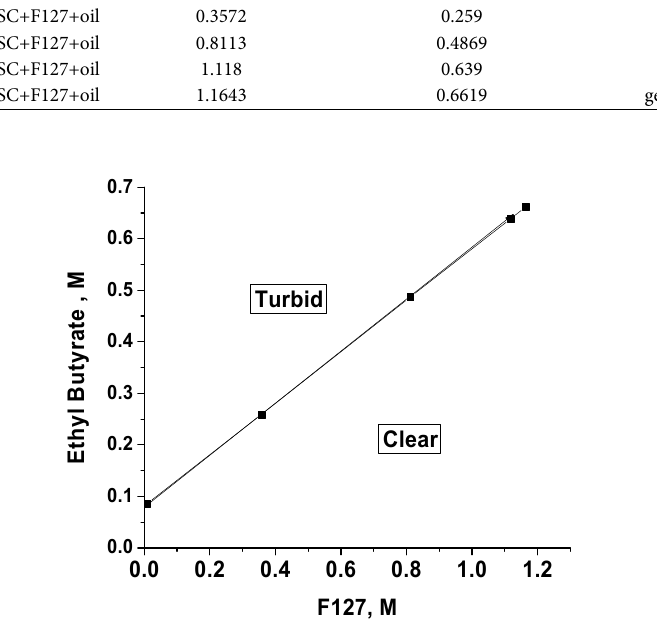
Fig. 3. Titration of microemulsions with Ethyl butyrate oil and F127 surfactant. The solution is clear below the curve and turbid above the curve.